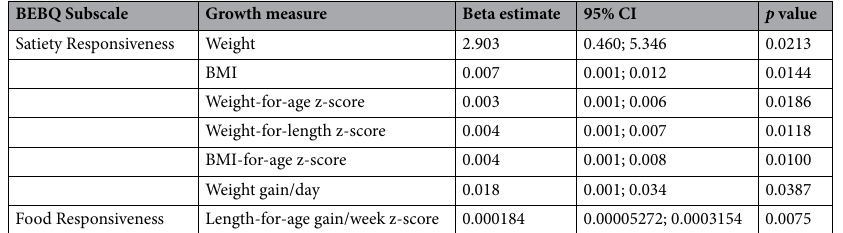
Table 3. Model estimates from linear regression analyses of Baby Eating Behavior Questionnaire (BEBQ) subscales AUC and infant growth, N = 41. Models adjusted for maternal age at birth, gender, birthweight, and mode of delivery. BEBQ subscale AUCs computed up to 6 months. Infant growth measured at 6 months.